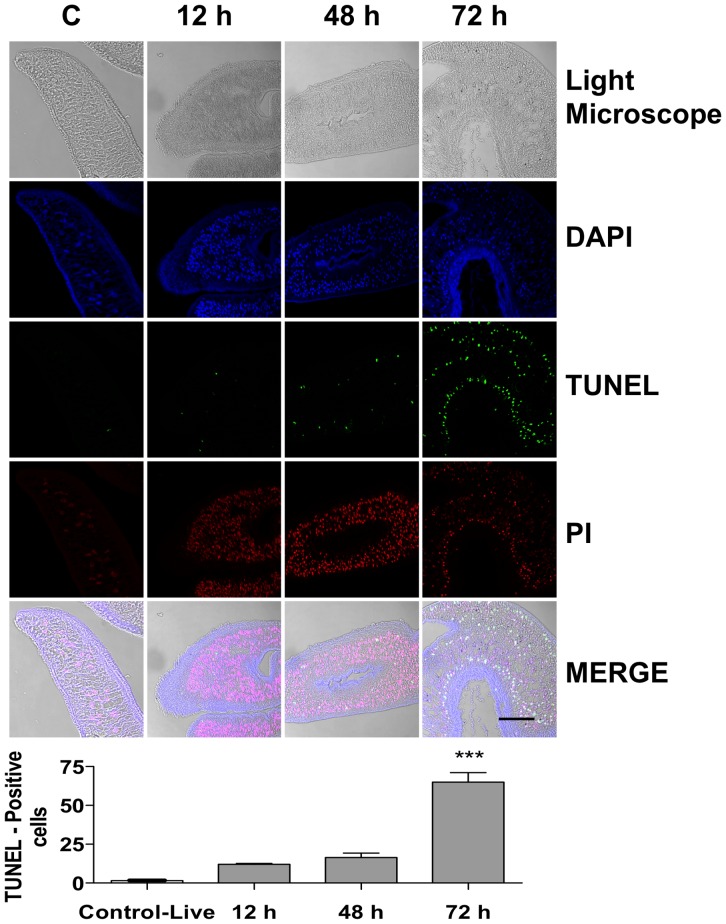
Edelfosine-induced apoptosis-like death as assessed by TUNEL assay.Adult worms were untreated (Control) or treated with 20 µM edelfosine (EDLF) for 12 h, 48 h and 72 h. Worms were analyzed by fluorescence microscopy for propidium iodide (PI) staining and TUNEL assay, as well as for DAPI staining (nuclei) and light microscopy morphology. Merging of PI and TUNEL panels (Merge) shows the apoptotic nuclei in yellow. Data shown are representative of four independent experiments. Histograms indicate the percentage of TUNEL-positive cells, as an estimate of cells undergoing apoptosis. For each experiment, at least 100 cells were analyzed. Data are means ± SEM of three separate experiments. Asterisks represent statistical significance with respect to control-live group. (***) P<0.001. Scale bar, 100 µm.